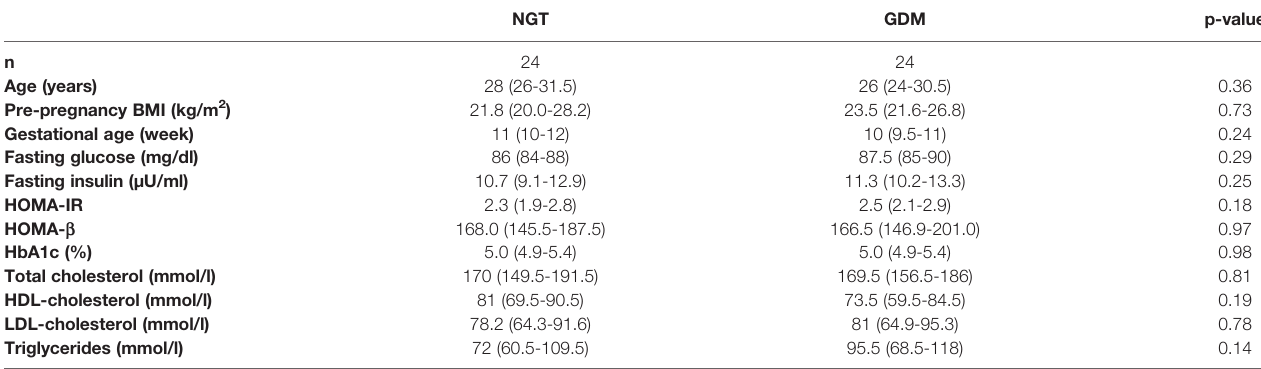
TABLE 1 | Clinical characteristics of groups studied in the 1 st